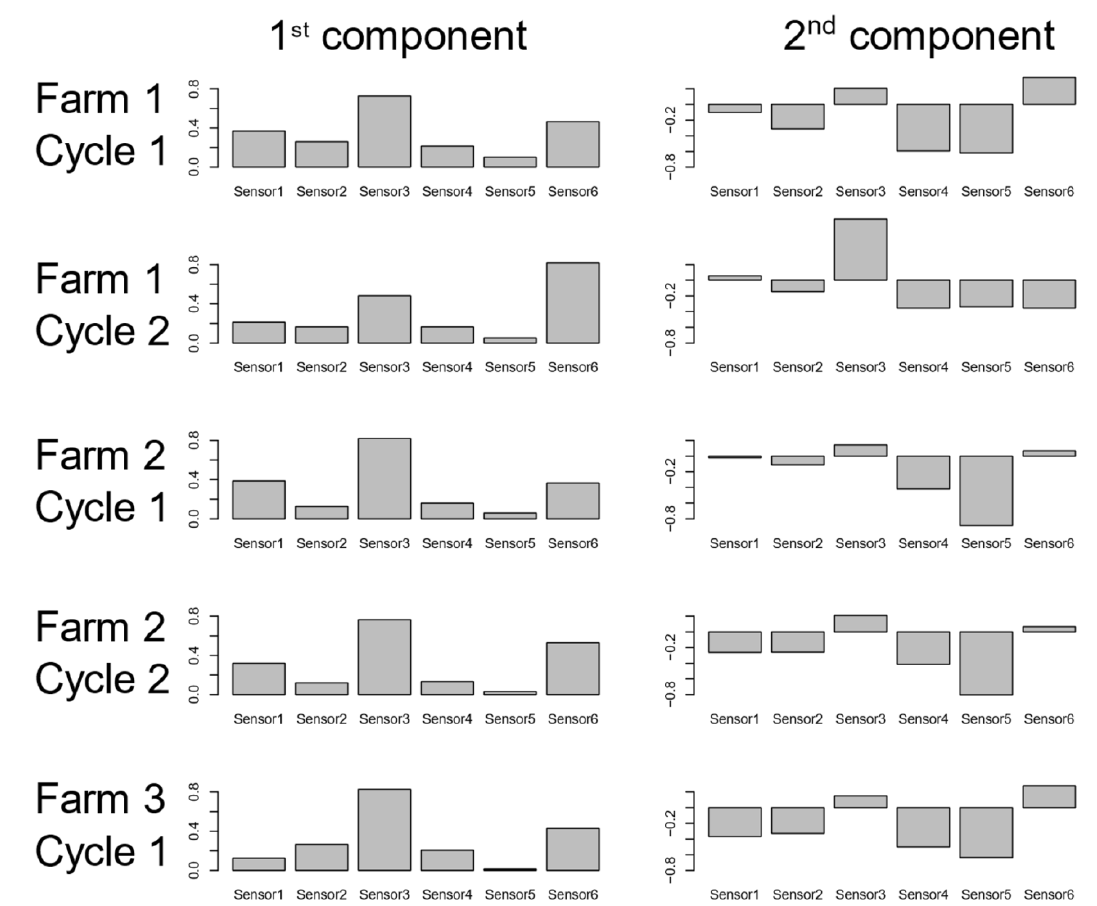
Figure 3. Barplot of the loadings of the first two principal components for each cycle of the three farms in the training set.